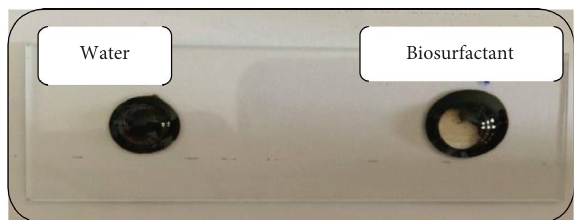
Figure 2: Drop collapse assay. Biosurfactant collapsed the hy- drocarbon drop, while water was repelled from the hydrophobic surface.